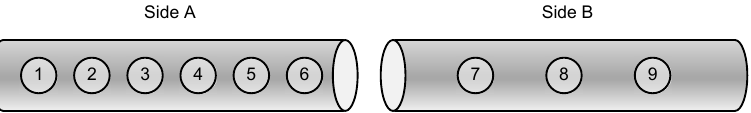
Figure 5. Map of defects on both side of the down tube and impact energy in